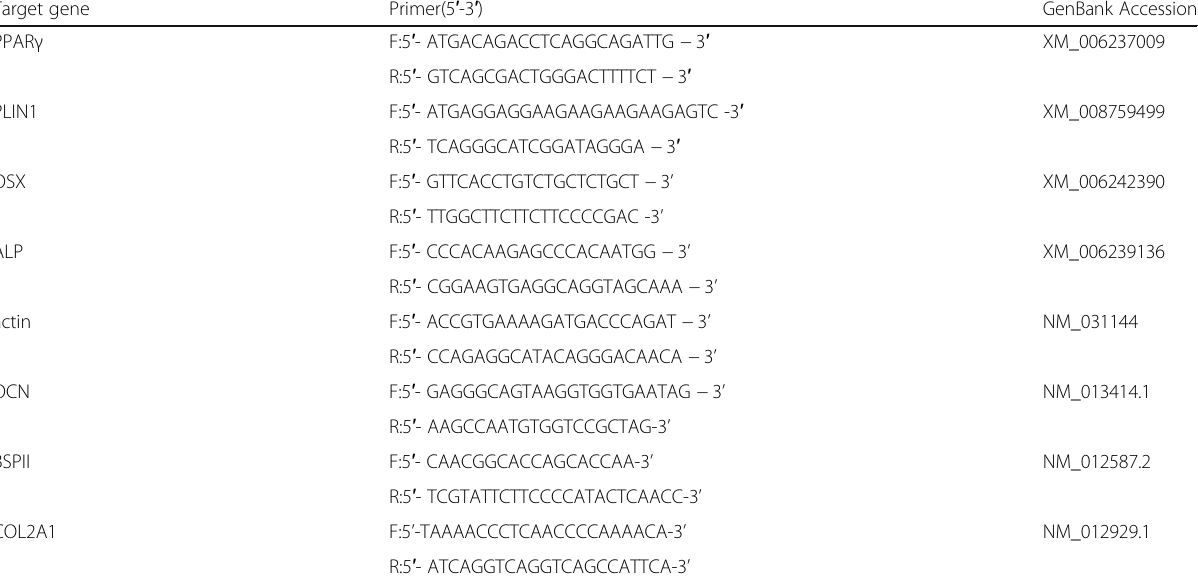
Table 1 Primers for qRT-PCR Target